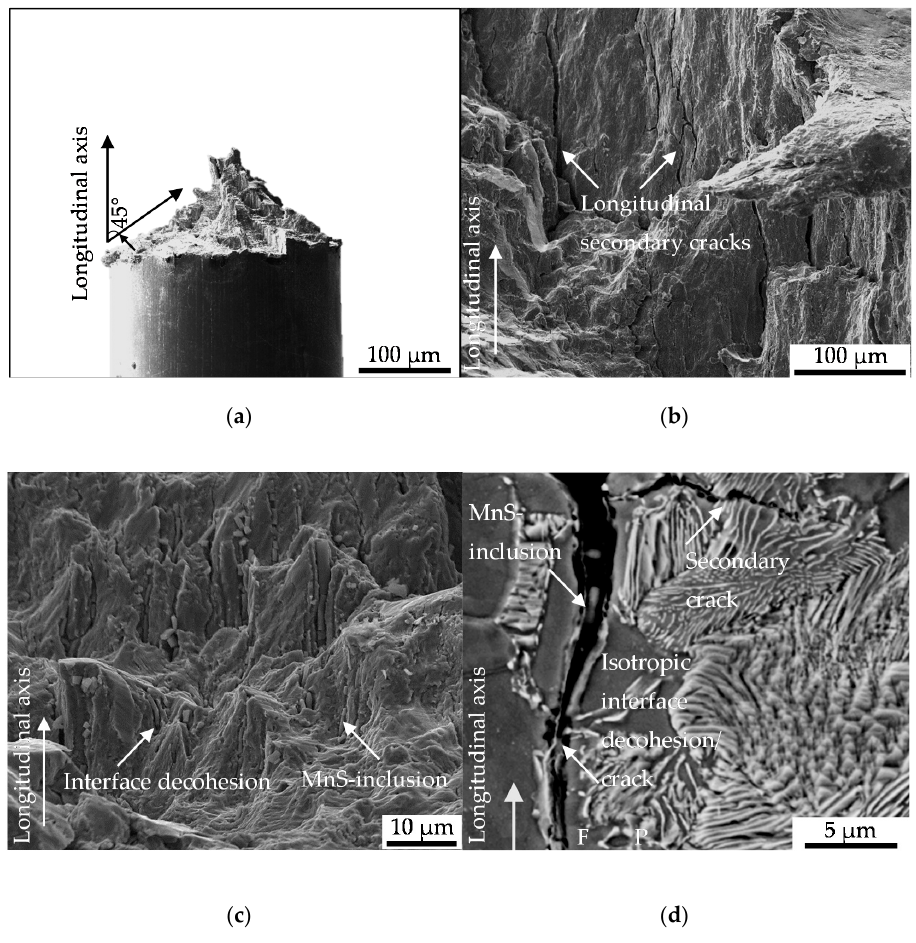
Figure 9. ( a ) Fractographic macro crack paths; ( b ) longitudinal cracks evolving in the material volume; ( c ) interface decohesion of metallic matrix and MnS inclusion due to cyclic damage evolution; ( d ) exemplary ferrite (F) – pearlite (P) phase localization of longitudinal cracks following isotropic crack growth in the material volume visualized after performed etching with Nital 3%.